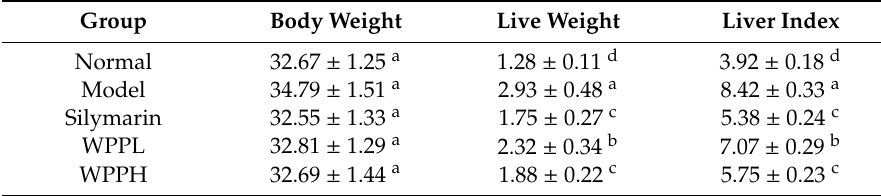
Figure 2. Body weight of mice during the whole experiment. Silymarin: mouse treated with 100 mg / kg silymarin; WPPL: mouse treated with 50 mg / kg white peony polyphenols; WPPH: mouse treated with 100 mg / kg white peony polyphenols. Table 2. Liver index of mice treated with